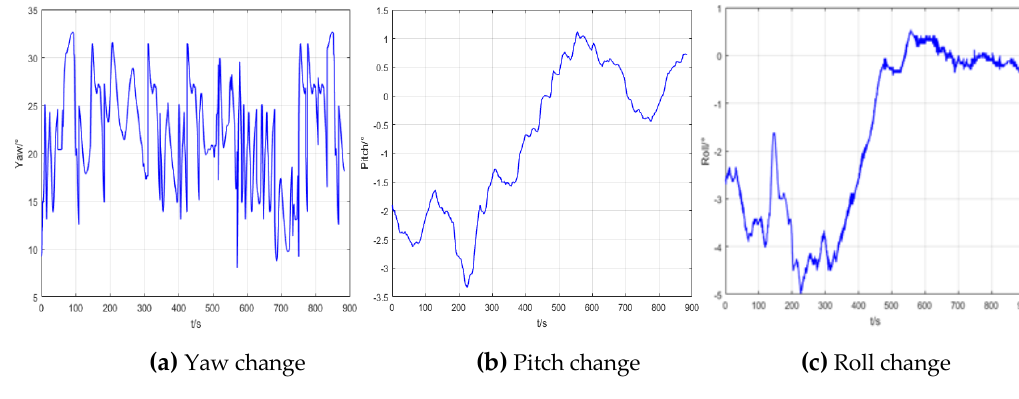
Figure 6. The change in attitude.